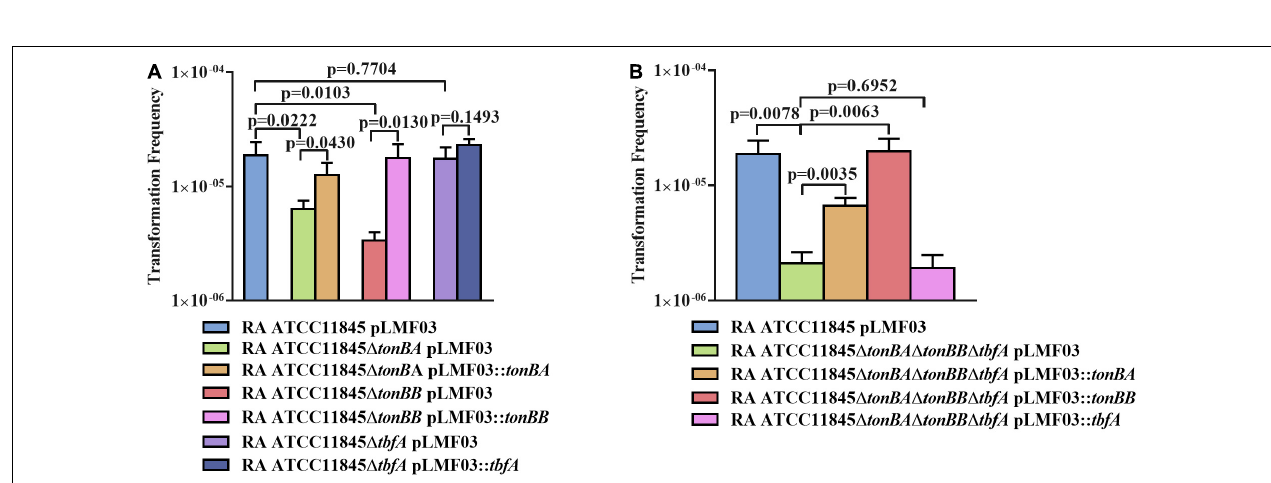
FIGURE 5 | The effect of tonB mutant on the natural transformation of R. anatipestifer ATCC 11845 in GCB. (A) The natural transformation frequency of the tonBA , tonBB , or tbfA mutants of R. anatipestifer ATCC 11845 in the GCB medium. (B) The natural transformation frequency of the tonBA–tonBB–tbfA triple mutant of R. anatipestifer ATCC 11845 and the single TonB complementation strain in the GCB medium. Natural transformation assay was performed using the standard method as described in section “Materials and Methods.”